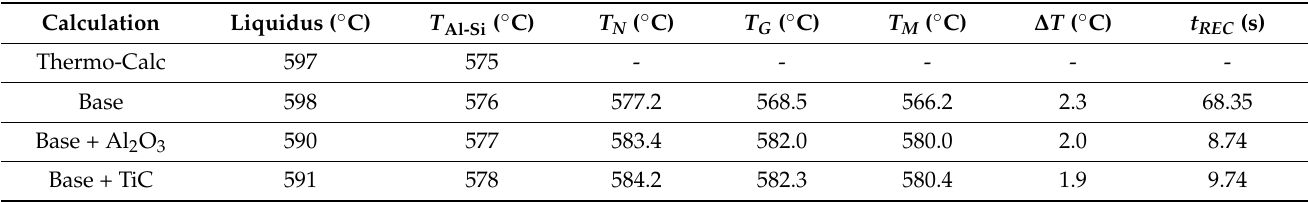
Table 4. Solidification properties of the studied